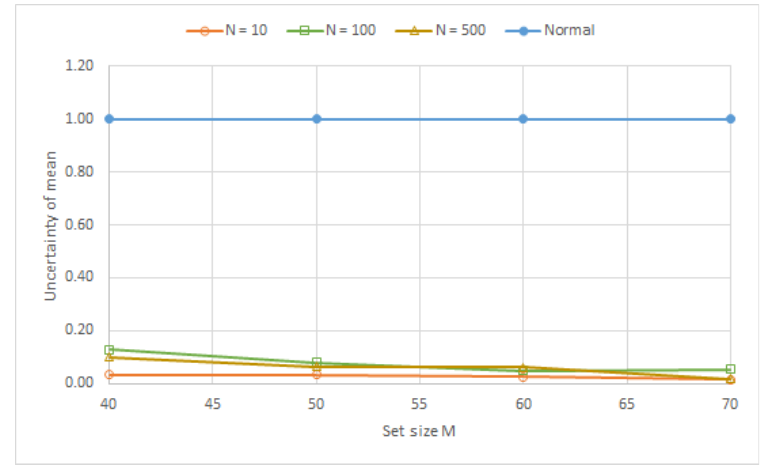
Figure 10. Deviation from the average relative to normal of the means.